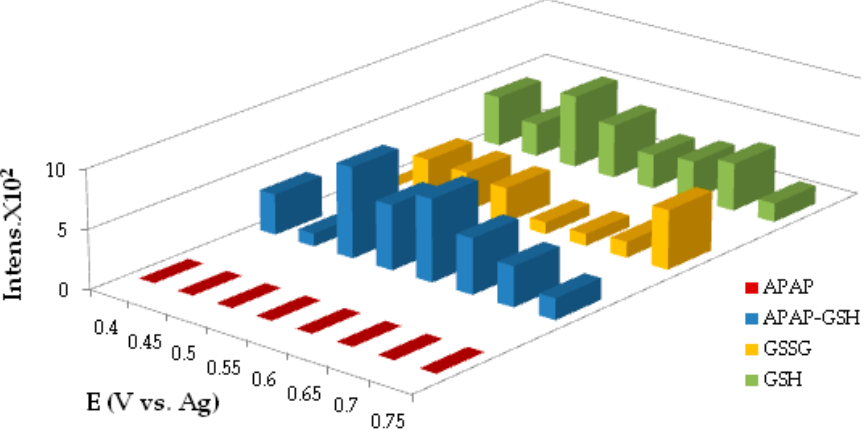
Figure 14. Potential optimizations of acetaminophen (APAP) electrochemical metabolism.